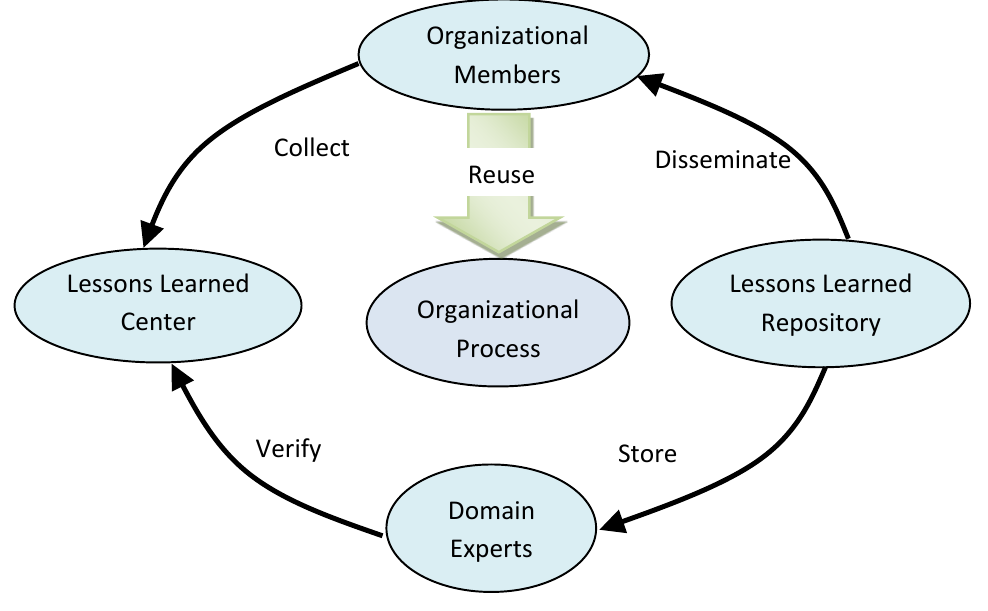
Fig.1. Lesson Learned Process (Weber et al.,